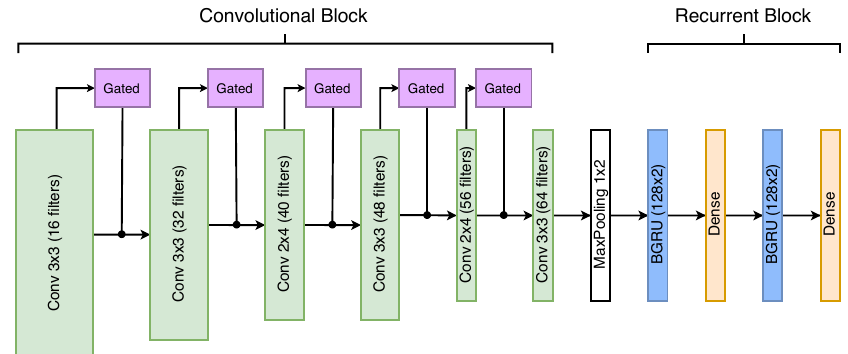
Figure 3. Proposed optical model architecture.